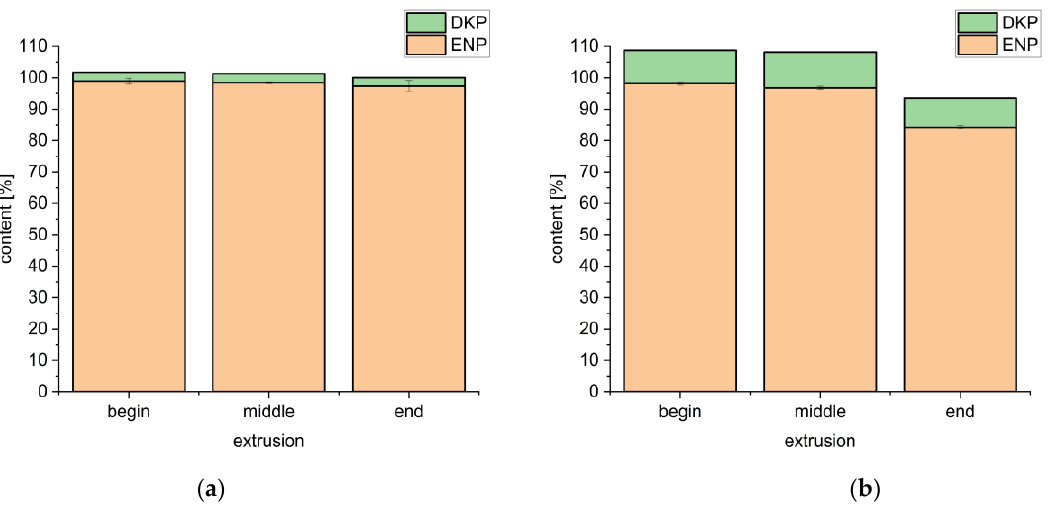
Figure 8. Enalapril and diketopiperazine derivative contents over the extrusion processes at 100 °C of formulation 5 ( a ) and formulation 6 ( b ) ( n = 10, mean ± SD).